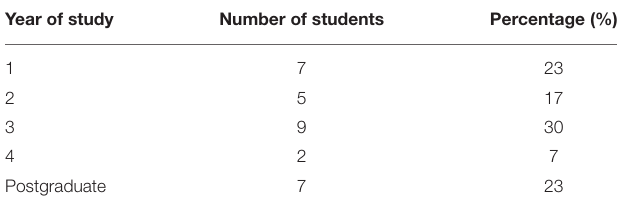
TABLE 2 | Number of students per year of study.